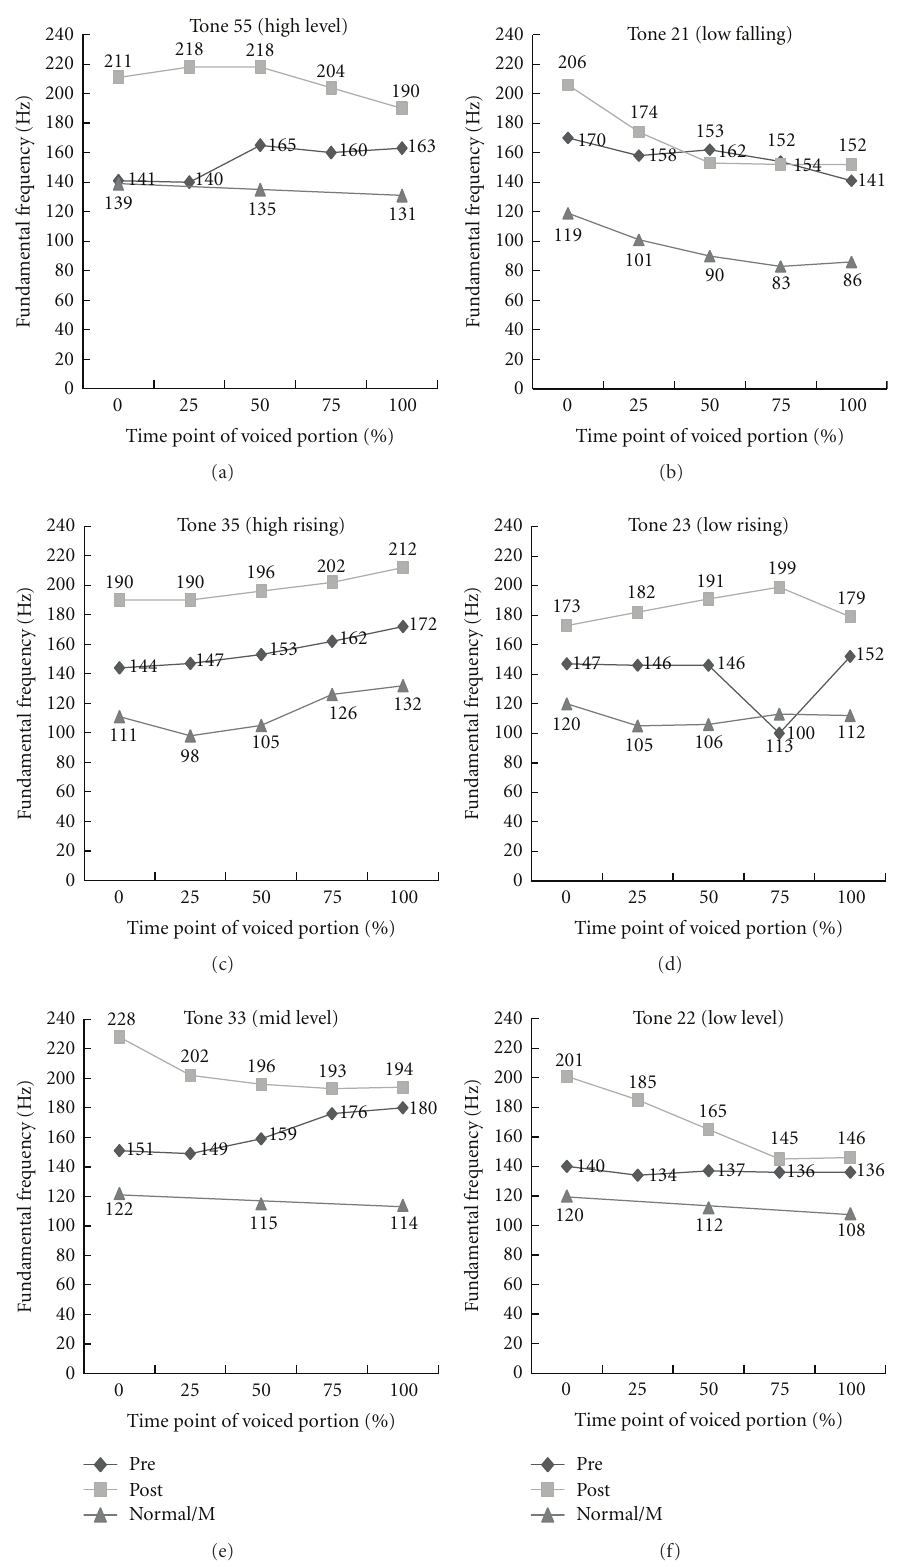
Figure 4: F0 pattern of six lexical tones produced by a 56-year-old male, CWY. The normative data are from Whitehill et al. [21, 22], cited in Whitehill and Wong